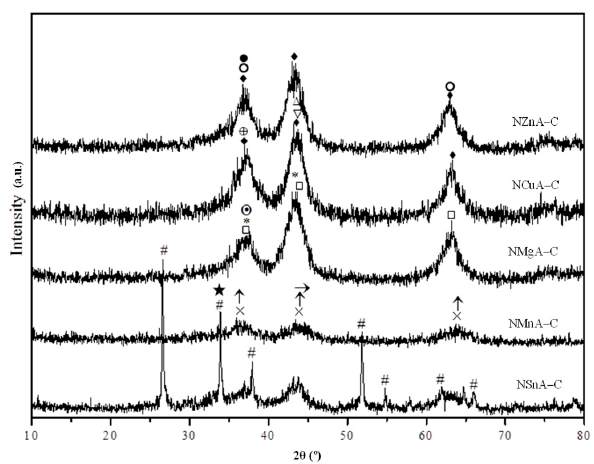
Figure 2. XRD patterns of different calcined catalysts derived from hydrotalcite. ◆ : NiO; ○ : ZnO; ● : ZnAl 2 O 4 ; ⨁ : CuAl 2 O 4 ; ▽ : AlNi 3 ; △ : AlCu 4 ; □ : MgAl 2 O 4 ; *: Al 2 Mg; ⨀ : Mg 2 Ni; ×: Al 2 O 3 ; ↑ : Mn 3 O 4 ; → : MnO 2 ; #: SnO 2 ; ★ : Sn 3 O 4 .